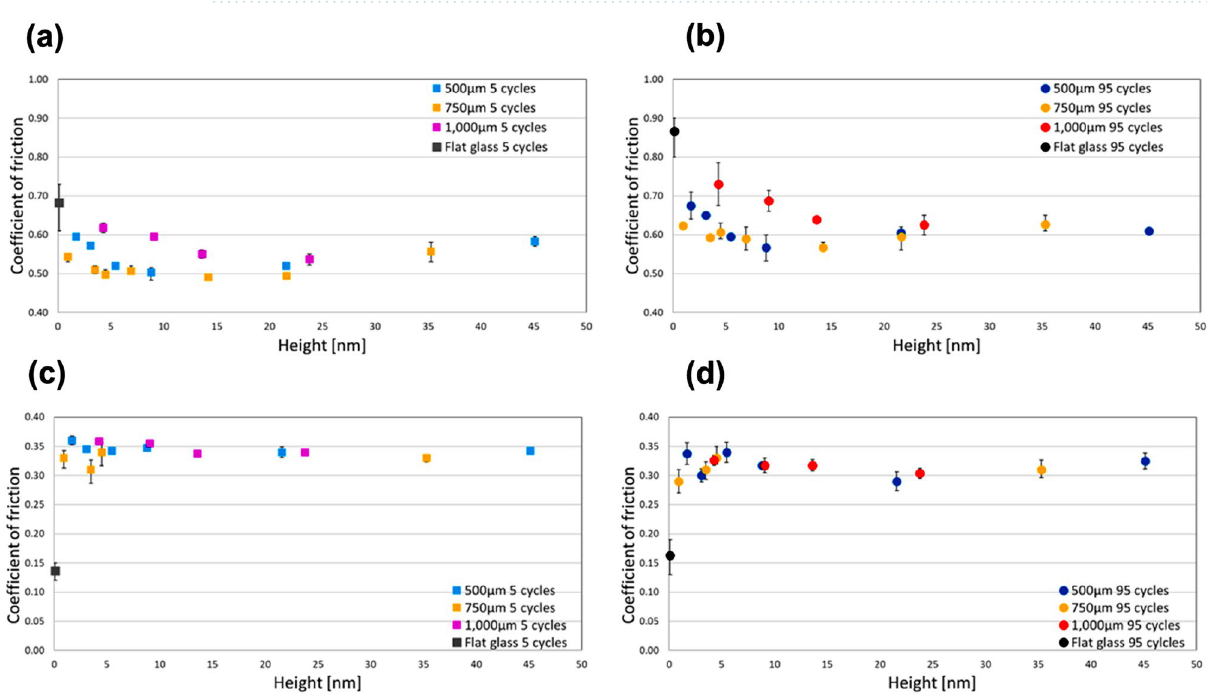
Figure 2. Relation between the friction coefficient and the convex-concave height in the glass surfaces for the elastomer and polyacetal tips. ( a ) Elastomer after 5 cycles; ( b ) Elastomer after 95 cycles; ( c ) Polyacetal after 5 cycles, ( d ) Polyacetal after 95